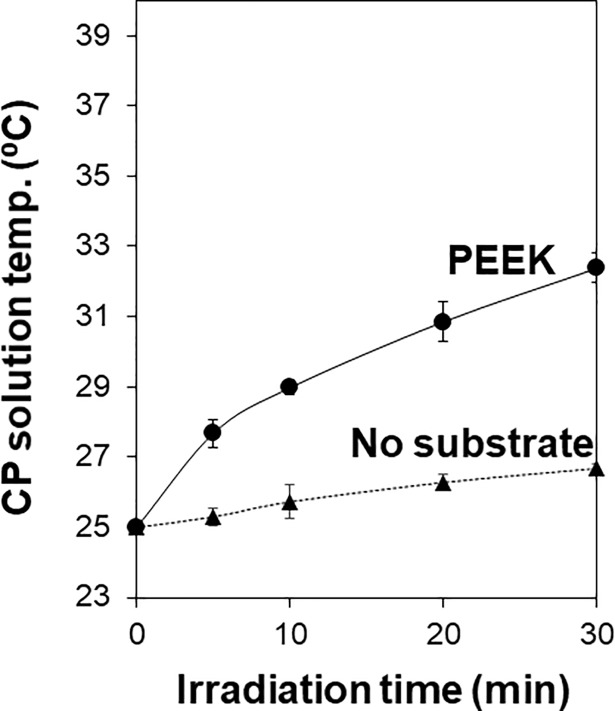
Temperature variations of the CP solution with and without the PEEK substrate during laser irradiation at 2 W/cm2 without a temperature-controlled water bath.Data are expressed as the average ± standard deviation (n = 4).